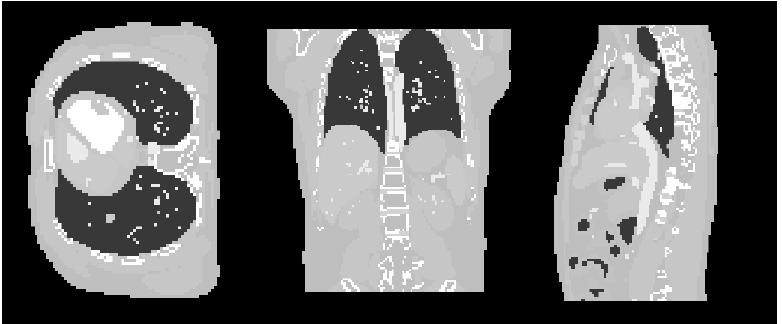
Figure 2. The original XCATphantom data used to simulate input projection data for the experiments. Cross-sectional slices are shown in transverse, coronal and sagittal planes.